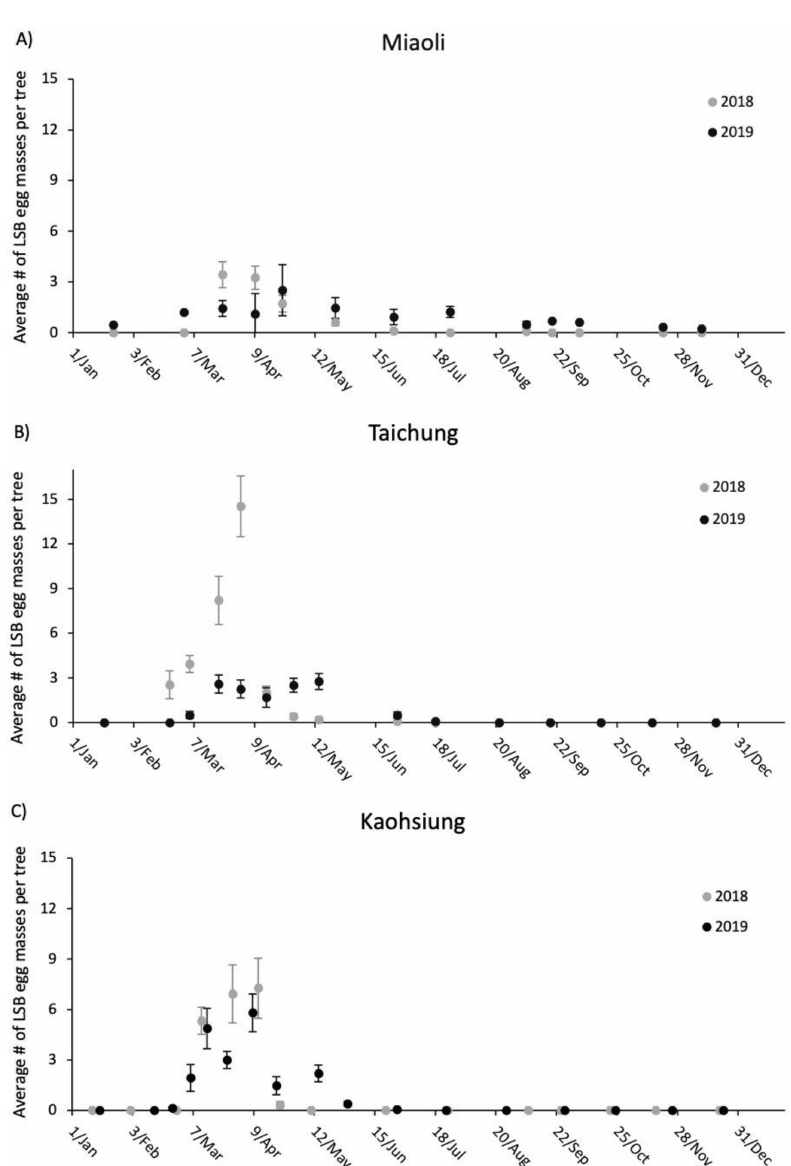
Figure 4. Dot plots with standard error bars of average number of observed LSB egg masses per tree from January through December at Miaoli ( A ), Taichung ( B ), and Kaohsiung ( C ) for 2018 (grey) and 2019